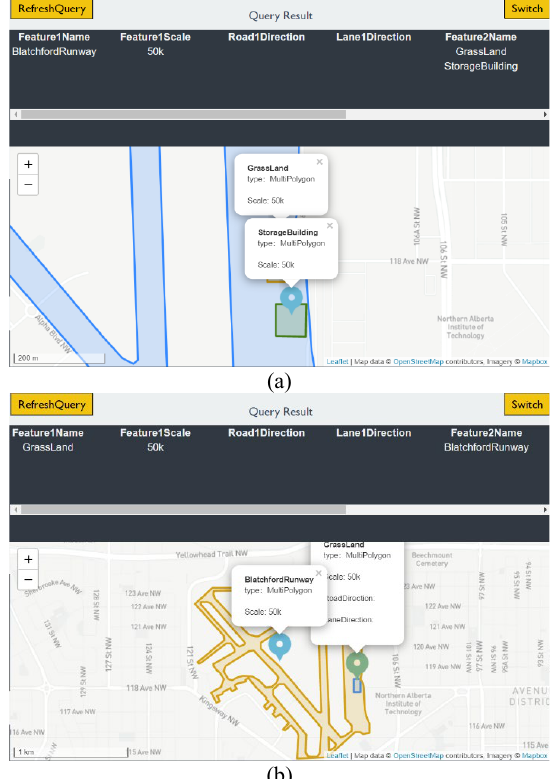
Figure 13 . (a)Results of finding geometries that are contained by Blatchford Runway. (b) Result of find geometries that Grass Land is within.